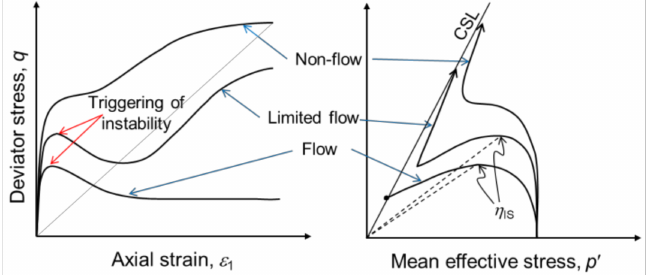
Figure 1. Three typical types of undrained behaviour observed in triaxial undrained tests